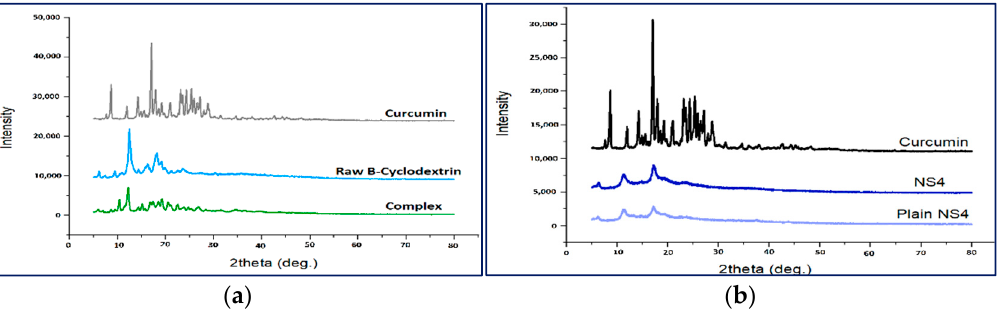
Figure 4. PXRD patterns of ( a ) curcumin- β -cyclodextrin complex; ( b ) curcumin-loaded nanosponges compared to the raw materials.